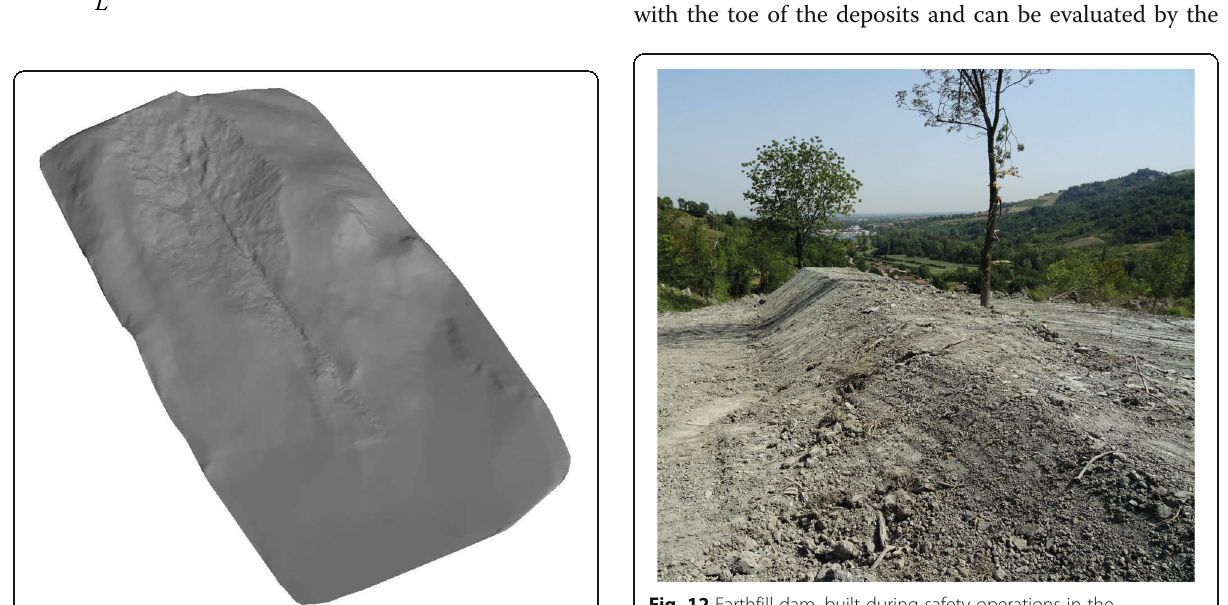
Fig. 11 DEM of the area